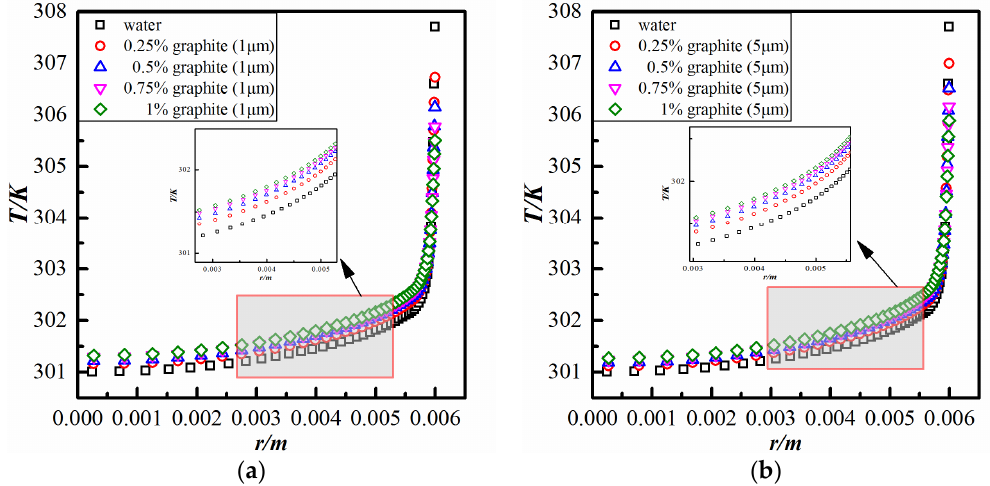
Figure 15. The temperature in the middle cross-section of the tube at Re = 23,000: ( a ) a graphite particle size of 1 μ m; ( b ) a graphite particle size of 5 μ m.